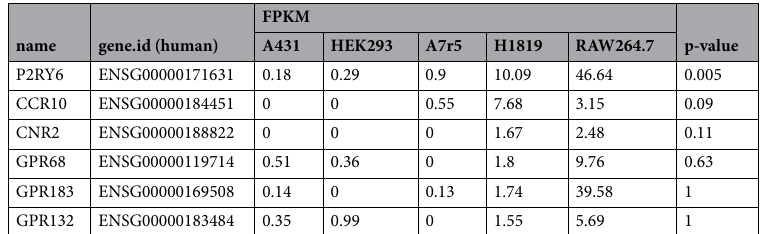
Table 1. GPCRs significantly expressed only in the PGE 2 -G-responding cell lines RAW264.7 and H1819. The p-value is from the differential expression analysis of the human cell lines ( see Methods